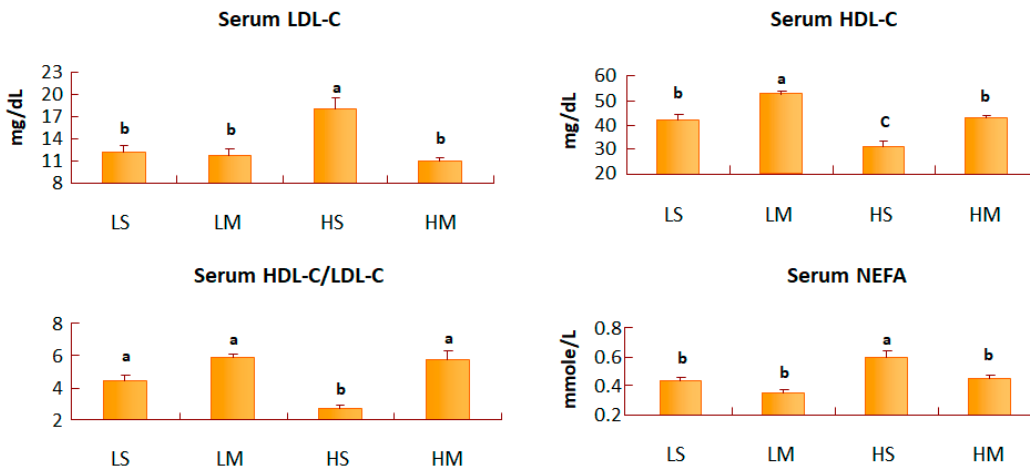
Figure 2. Serum low-density lipoprotein cholesterol (LDL-C), high-density lipoprotein cholesterol (HDL-C), the HDL-C/LDL-C ratio, and non-esterified fatty acid (NEFA) concentrations of type 2 diabetes mellitus rats fed the different diets for 8 weeks. Data are expressed as the mean ± SEM ( n = 8). LS, diet contained 16% soybean oil; LM, diet contained 8% soybean oil and 8% medium-chain triglyceride oil; HS, diet contained 58% soybean oil; HM, diet contained 29% soybean oil and 29% medium-chain triglyceride oil. Values with different superscripts significantly differ at p < 0.05.